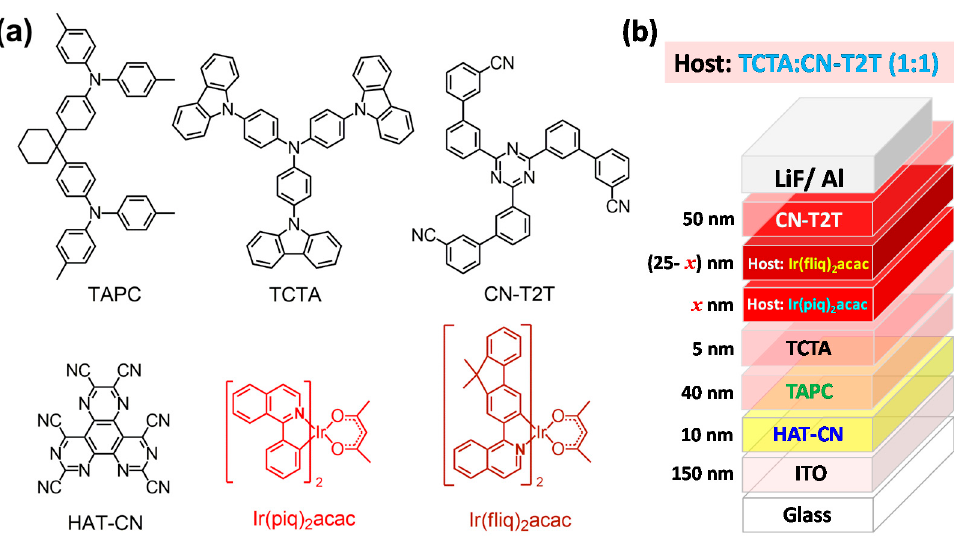
Figure 3. ( a ) Structural drawing of the materials and ( b ) schematic structures of the tested red OLEDs.